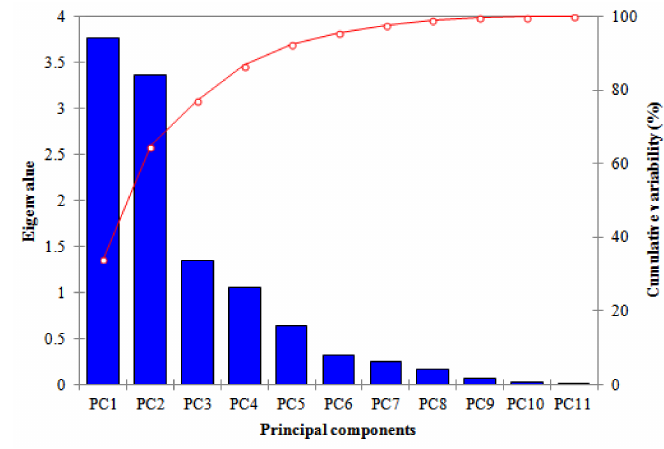
Figure 3. Eigenvalues and cumulative variability of the